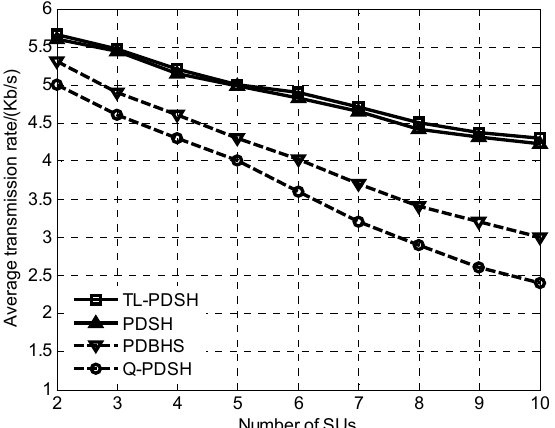
Figure 1. Average transmission rate versus number of SUs.